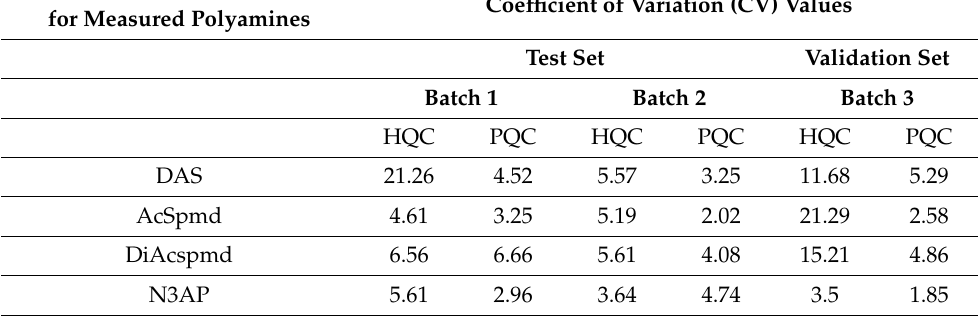
Late Stage OvCa Cases ( n = 75) vs. Healthy Controls ( n =